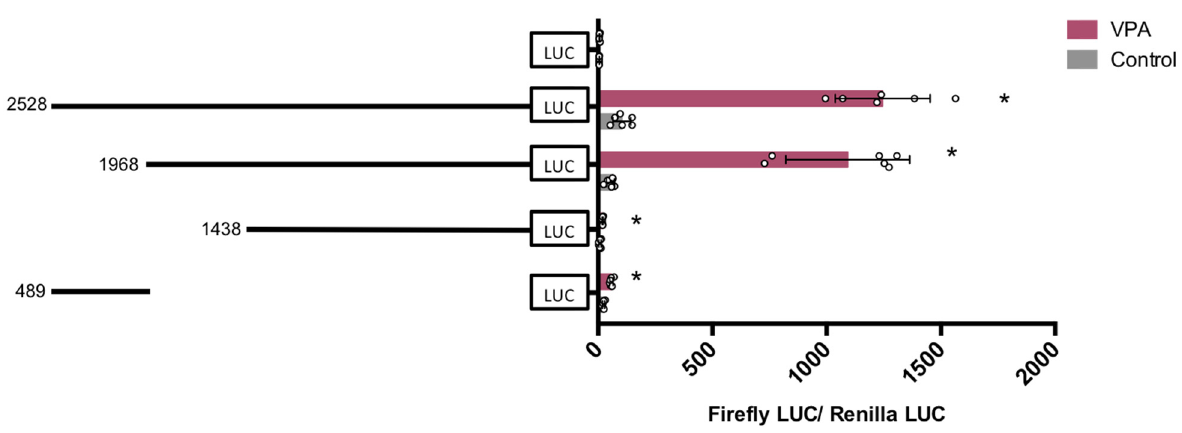
Figure 6. Response of four hVDR (human Vitamin D Receptor) gene promoter regions of 2528 bp, 1968 bp, 1438 bp, and 489 bp to VPA (valproic acid). HepG2 cells were transfected with the pGL4-VDR-2528 ( − 591 to +1937), 1968 ( − 98 to +1870), 1438 (+499 to +1937), and 489 ( − 591 to − 102) plasmids or pGL4 empty vector and treated with 5 mM VPA, or vehicle as control. Firefly luciferase activity was normalized with Renilla luciferase activity (relative light units, RLUs). Results are expressed as mean ± SEM from six independent experiments. * p -value < 0.05, t